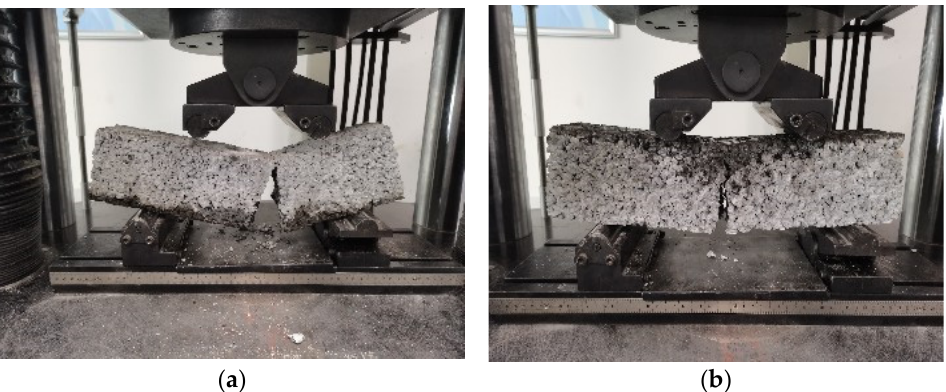
Figure 6. The flexural tensile failure patterns of ( a ) concrete prism without basalt fiber and ( b ) concrete prism with basalt fiber.